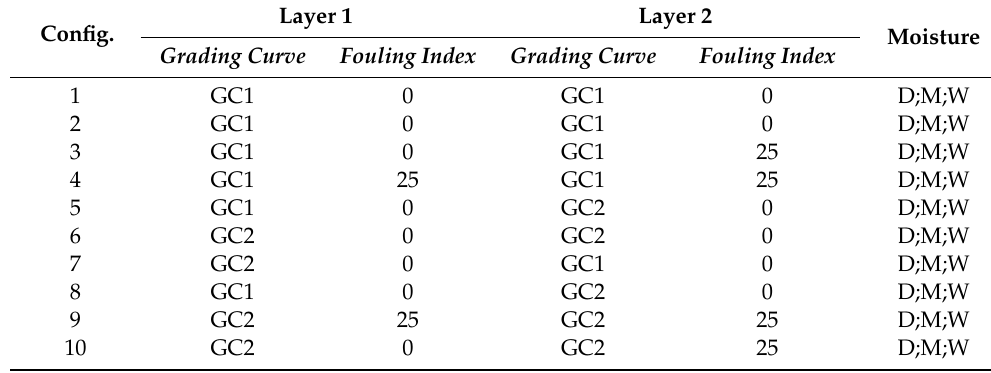
Table 1. Features of the tested configurations.